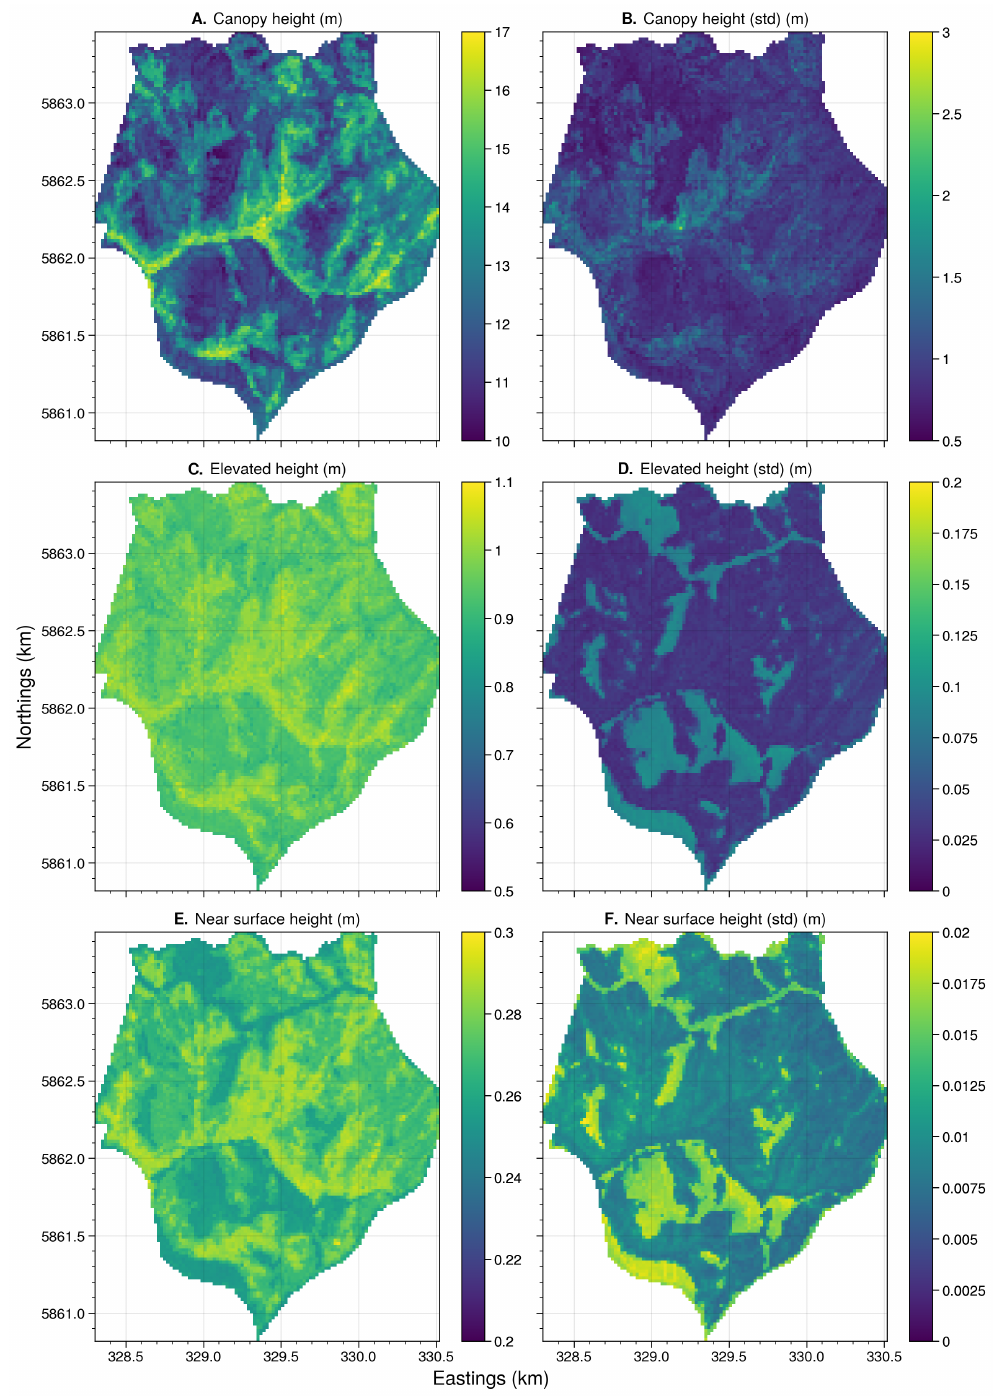
Figure 9. The mean and standard deviation predictions at landscape level for canopy ( A , B ), elevated ( C , D ) and near-surface ( E , F ) fuel height using TLS observations at Clonbinane. Consistent features of landscape were observed in predicted maps of canopy height for all sites (Figure 9A and all figures in Appendix B). The mean variation in canopy height across the up-scaled areas for all seven sites was found to be low ( < 1.4 m) (Figure 10). Relatively high variation in canopy height was observed in sites with low plot density (for instance, at Three Bridges (1.34 m) where only four plots were used to up-scale an area of 482.7 ha, the lowest variation (0.7 m) in model prediction was observed at the Tostaree site, which had the highest plot density (Figure